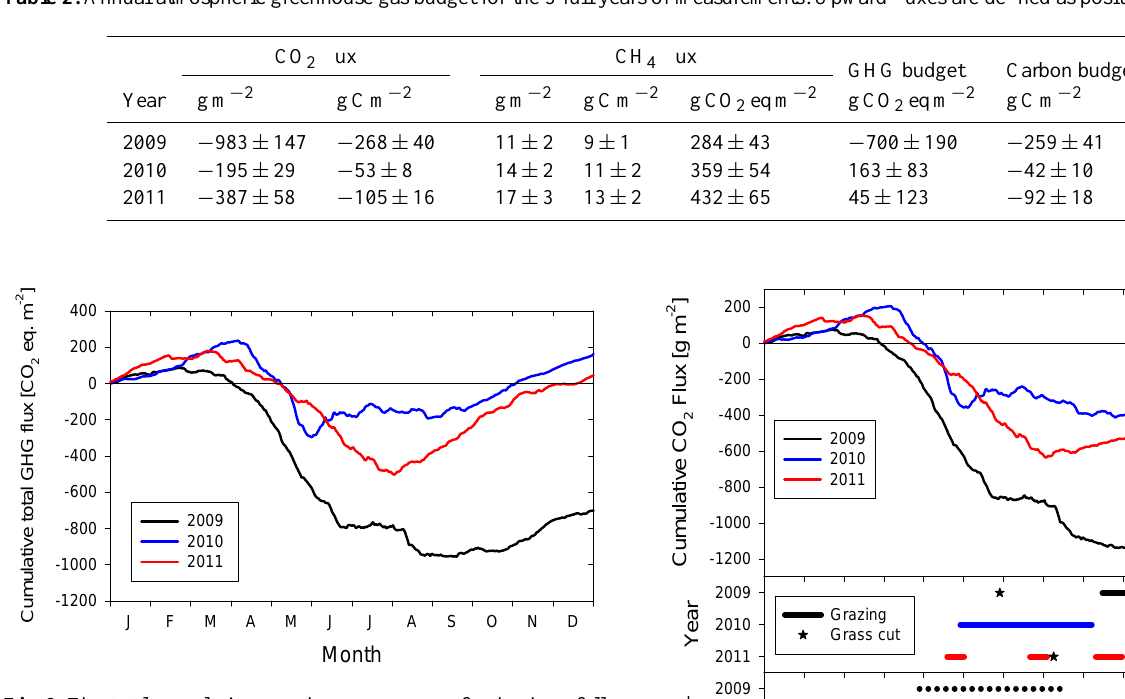
Fig. 2. The total cumulative greenhouse gas fluxes for the three full calendar years of measurements, including both CO 2 and CH 4 in CO 2 equivalents. Upward fluxes are defined as positive.